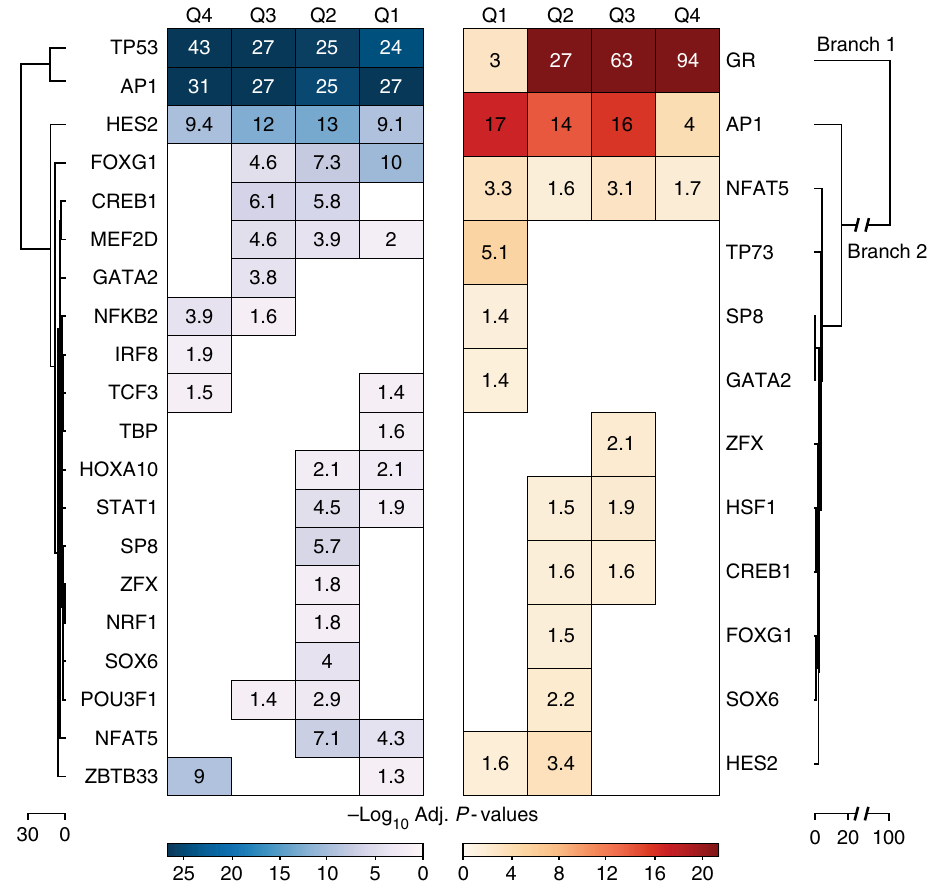
Fig. 3 Dex-responsive regulatory elements are enriched for TF-binding motifs. Dynamic DREs identi fi ed after 8 h of dex treatment were binned according to their fold change in reporter activity relative to steady state. Enriched motifs were identi fi ed for each quartile and then hierarchically clustered. Bonferroni- corrected log 10 P values are displayed for all signi fi cant